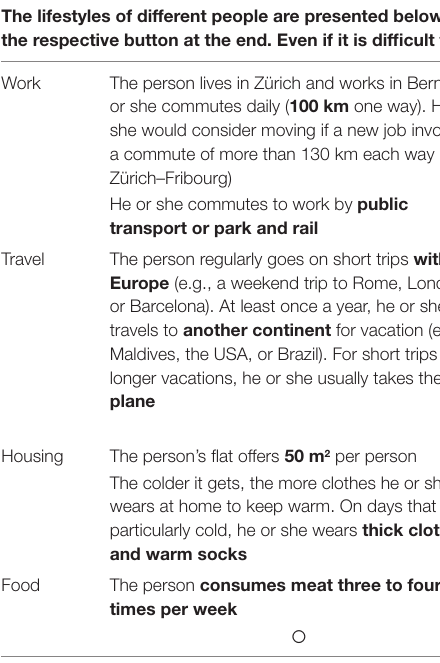
TaBle 2 | exemplary description of three lifestyles, as presented in the study. The lifestyles of different people are presented below. Please read through them carefully and choose the lifestyle that appeals to you the most. click the respective button at the end. even if it is difficult for you to choose, please select one. (1 of 10 decisions)